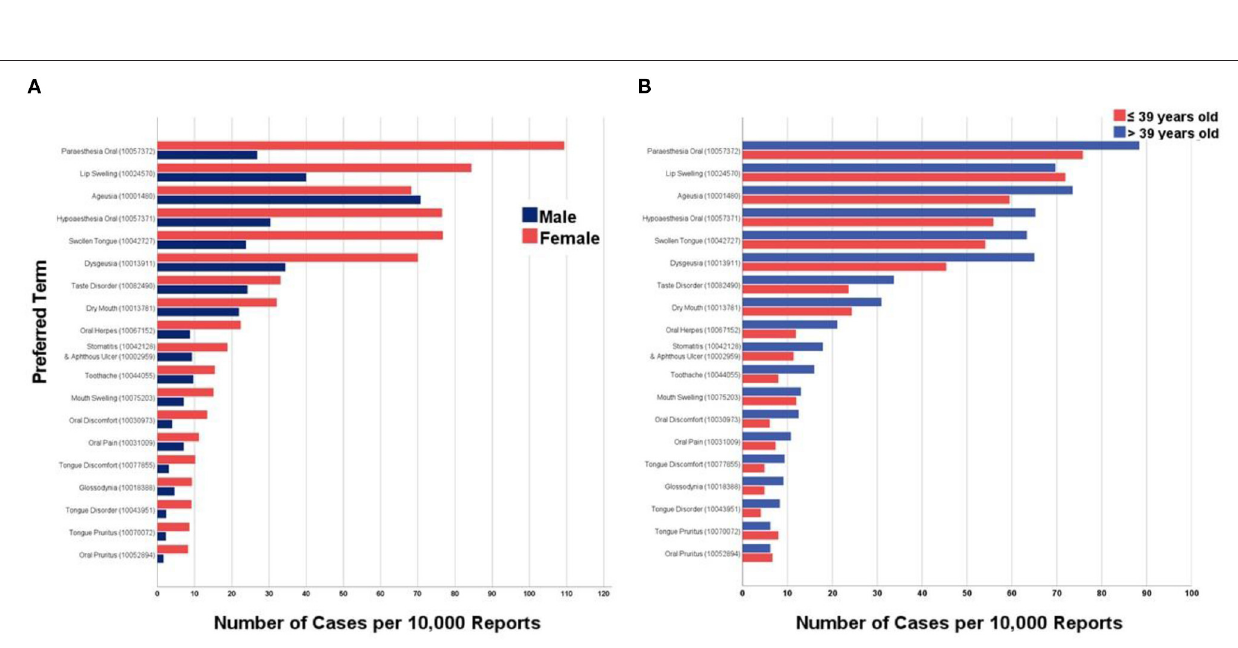
Frontiers in Public Health | www.frontiersin.org 8 July 2022 | Volume 10 | Article